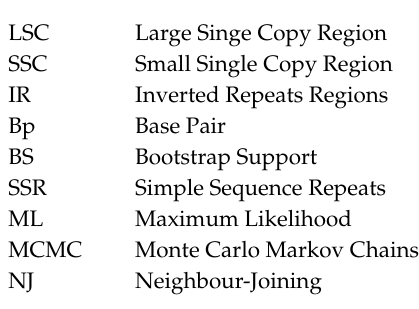
number and length of SSRs detected in analyzed plastomes, Supplementary File 1: The conditions of PCR reaction used during study, Figure S1: Read coverage LSC-IR border of Conocephalum salebrosum chloroplast genome. Figure S2: Phylogram of Marchantiidae derived from a Maximum Likelihood analysis of complete chloroplast sequences. The posterior probabilities values lower than 1 and bootstrap values lower than 100% are shown. The Bayesian analysis resulted in the tree with identical topology but unsupported (0.72 posterior probability) Dumortiera-Reboulia clade. Figure S3: Line plot of the barcode gap for the five species of Marchantiales. For each individual in the dataset, grey lines represent the furthest intraspecific distance (bottom of line value), and the closest interspecific distance (top of line